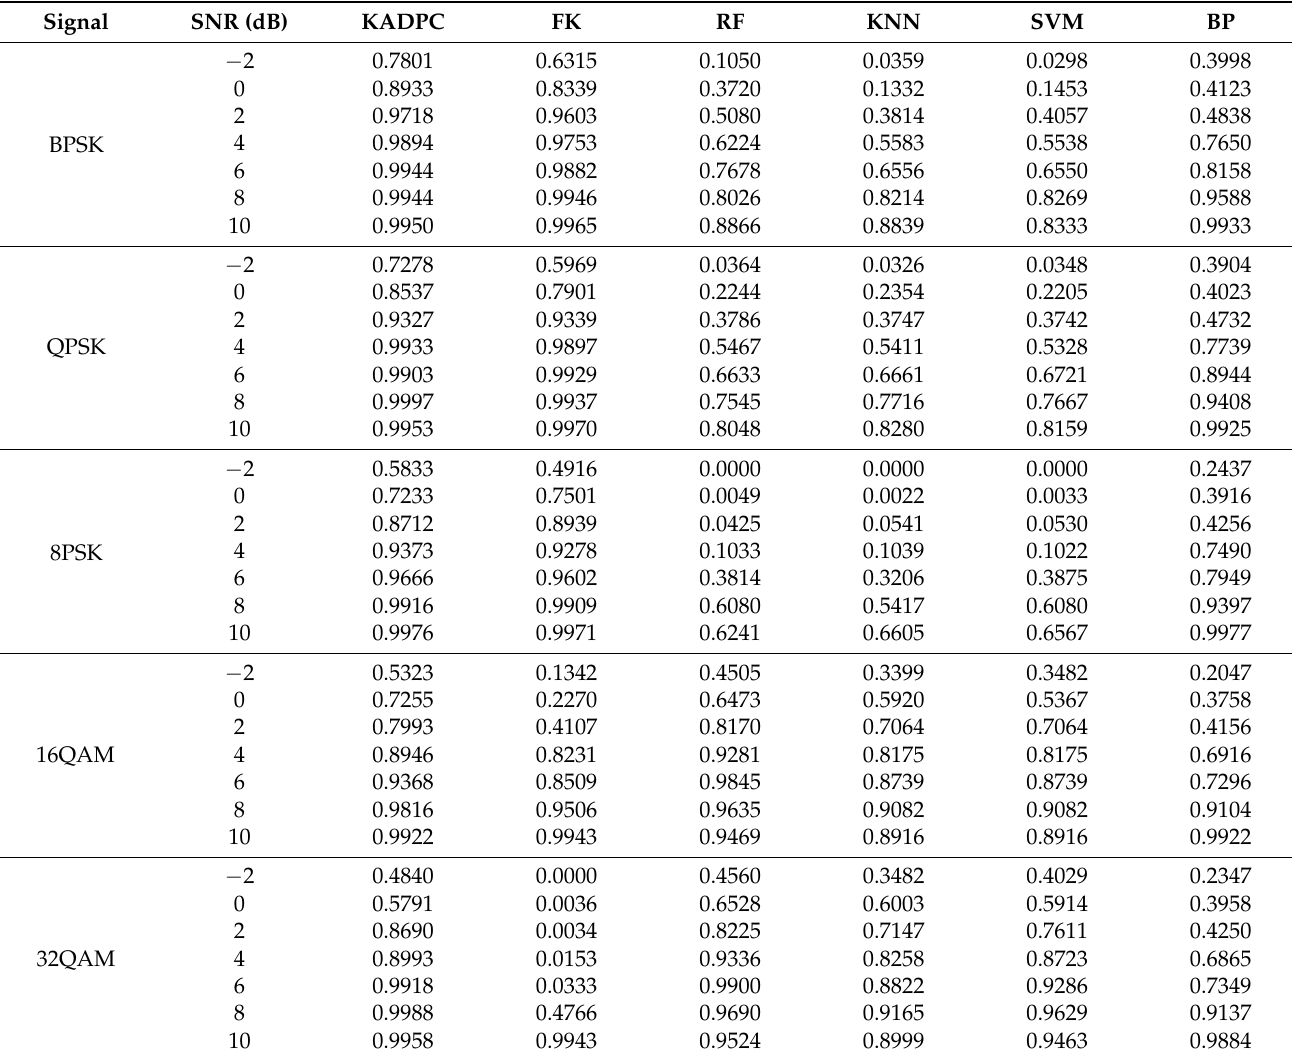
Table 1. Recognition accuracy of communication signals by different